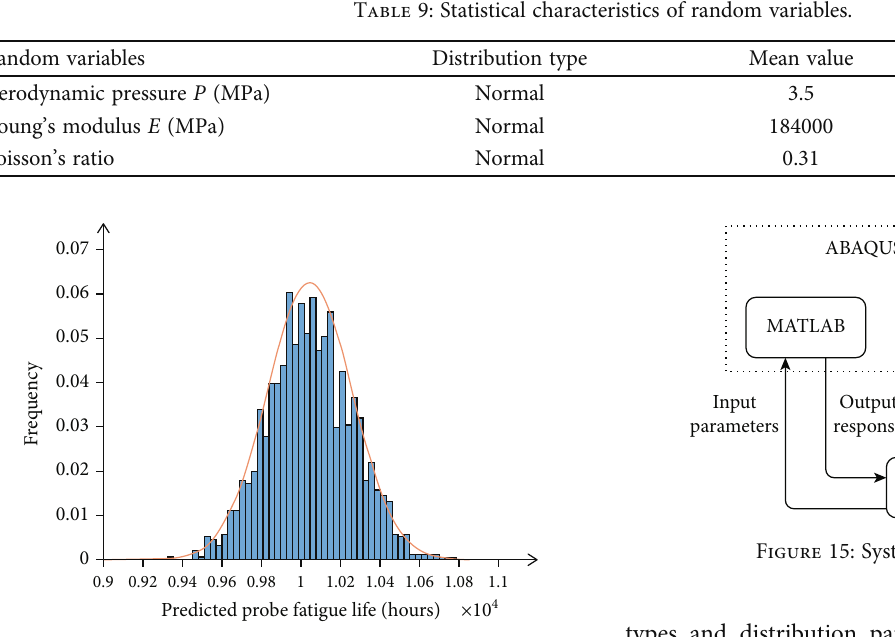
Figure 13: Distribution of probe fatigue life sample (Monte Carlo method).